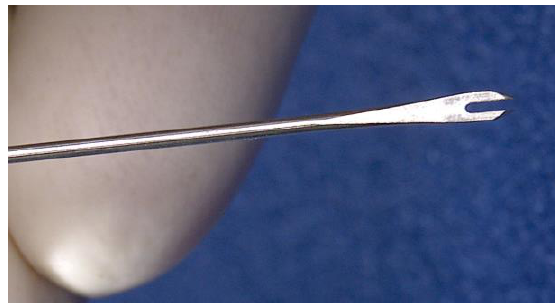
Figure 2. Bifurcated needle.